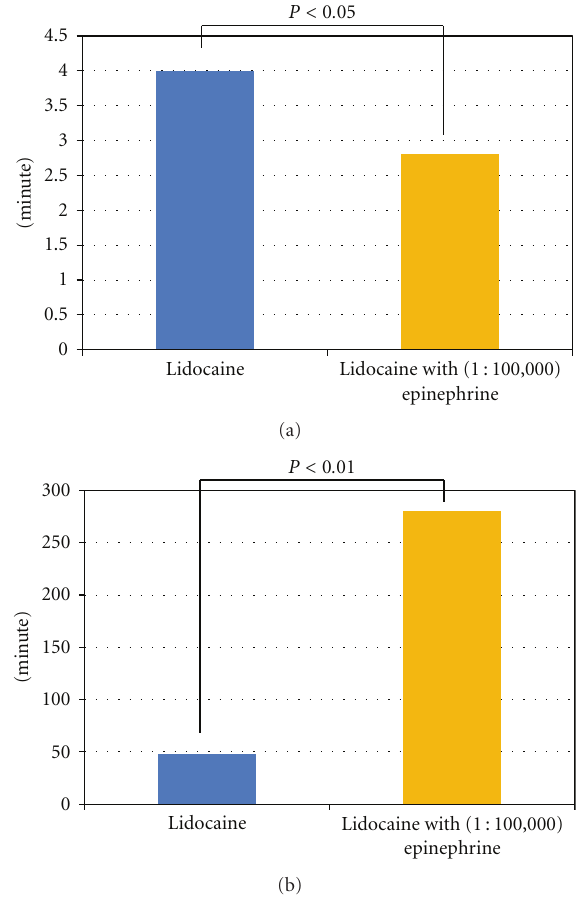
Figure 4: (a) Time to anesthesia. (b) Duration of anesthesia.